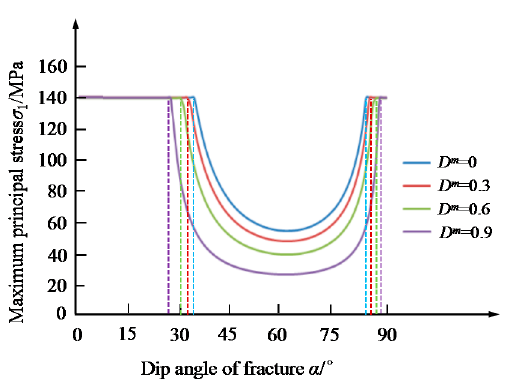
Figure 9. Effect of different water-dripping erosion factors on rock strength.